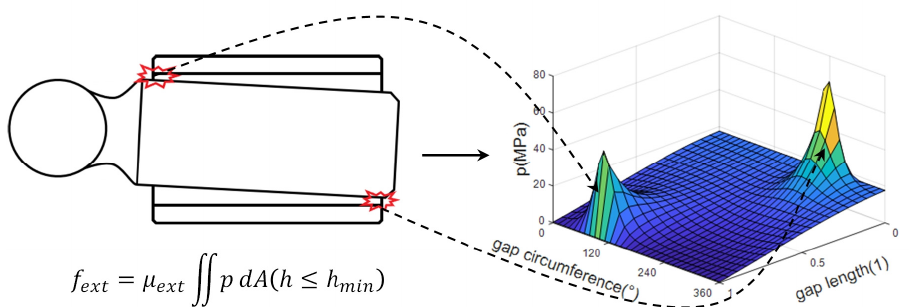
Figure 9. The extra friction force exerted on the piston.